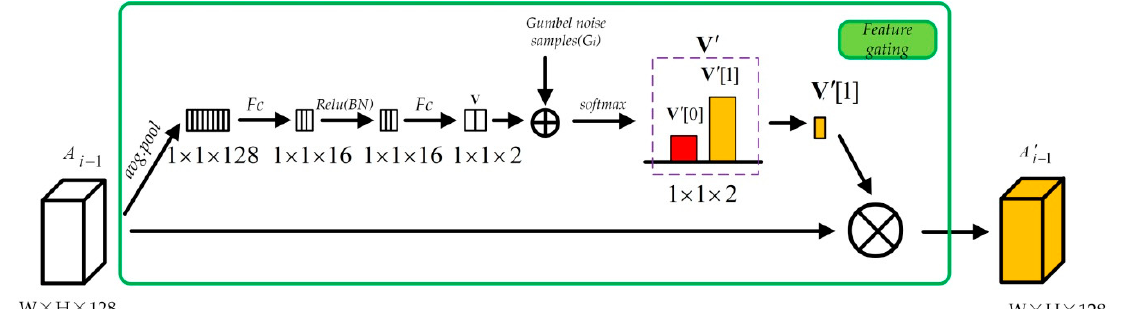
Figure 4. Schematic diagram of feature gating unit.